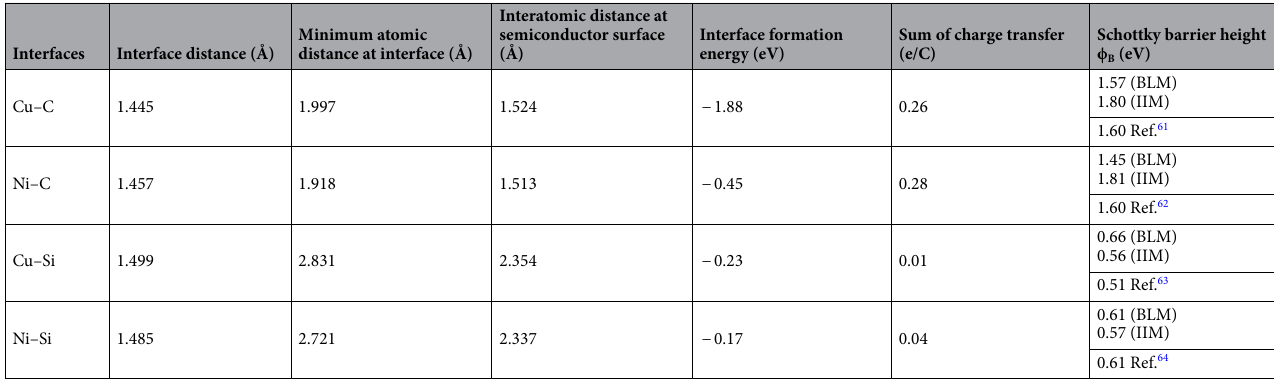
Table 2. The key parameters of the Ni–Si, Ni–C, Cu–Si and Cu–C interfaces after